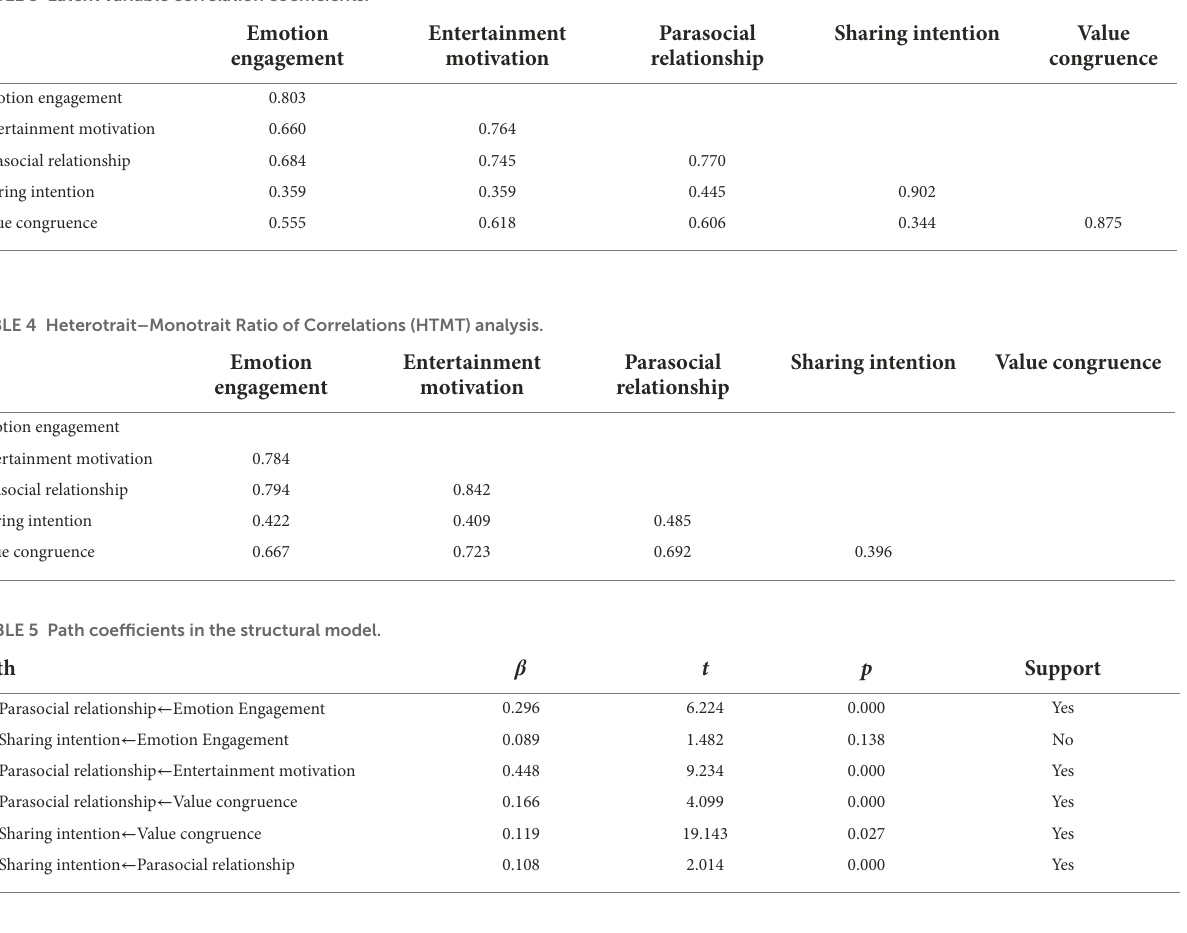
TABLE 3 Latent variable correlation coefficients.